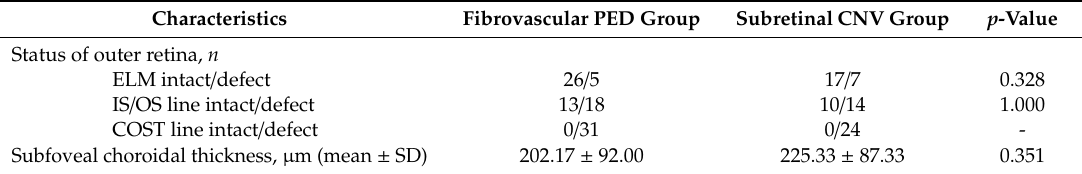
Figure 4. Graph illustrating changes in the amount of decrease in the photoreceptor layer (PRL) thickness. PRL thickness was continuously decreased in the fibrovascular PED and subretinal CNV groups for 2 years. However, the amount of decrease in PRL thickness was not different between the two groups during the 2-year follow-up. Table 2. Status of outer retina and choroid at 2 years on SD-OCT after intravitreal anti-VEGF agent injections.